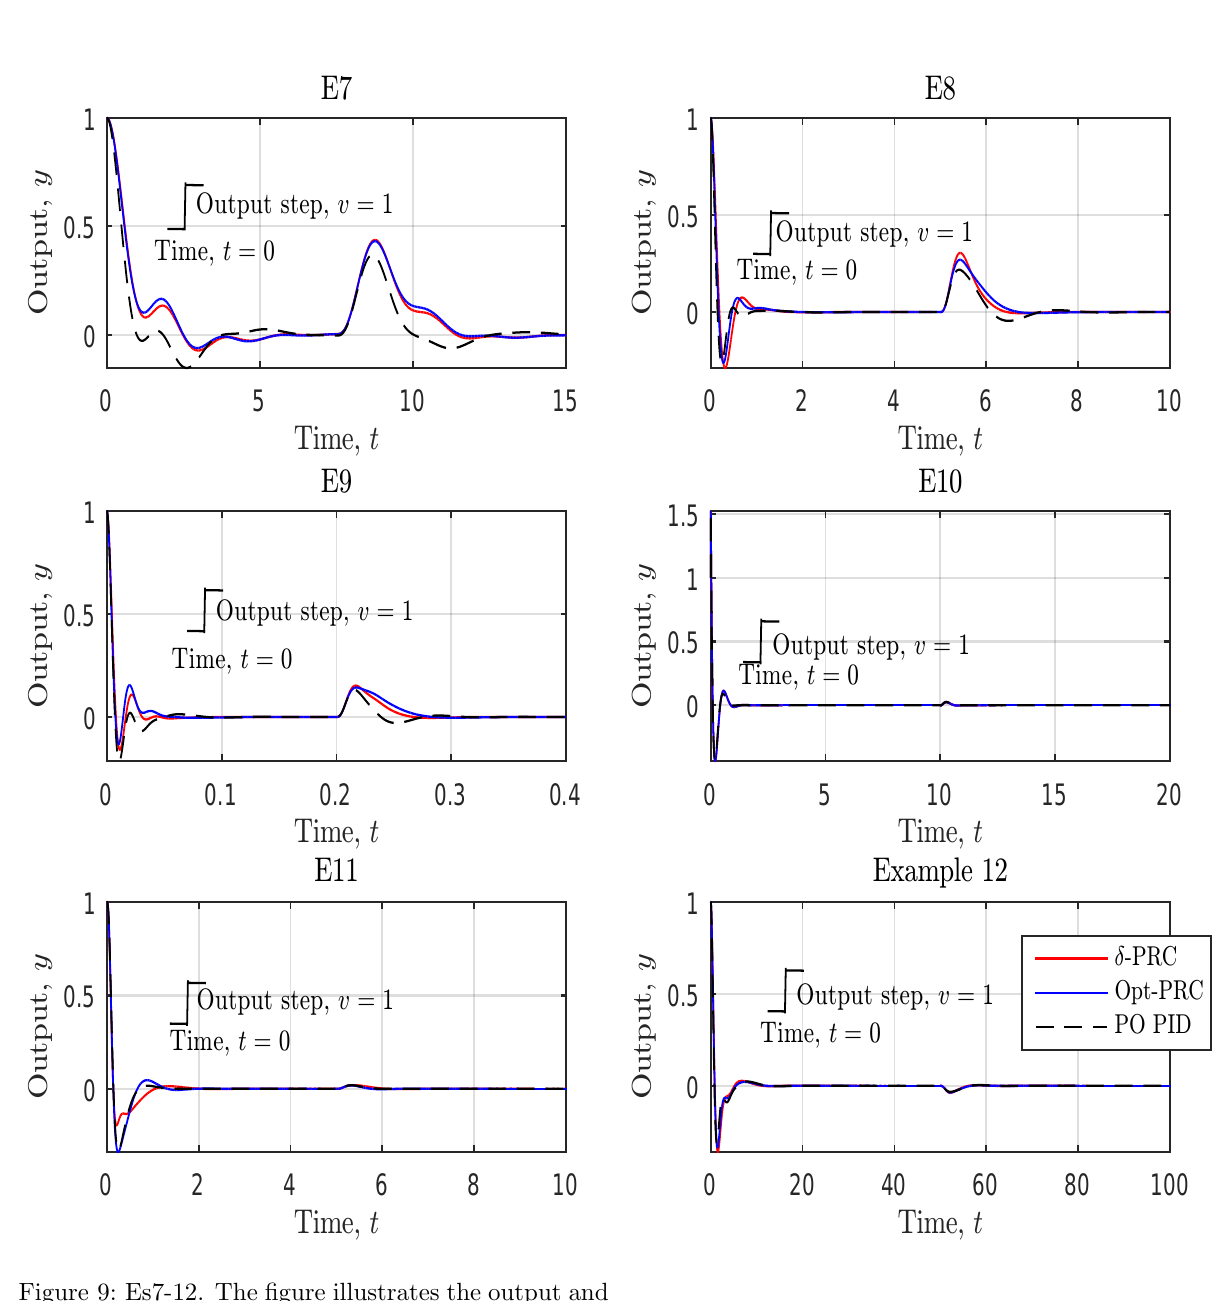
Figure 9: Es7-12. The figure illustrates the output and input step time-domain responses for a pre- scribed robustness, M s = 1 . 59, for the fol- lowing methods: δ -PRC, SIMC, K-SIMC and PO